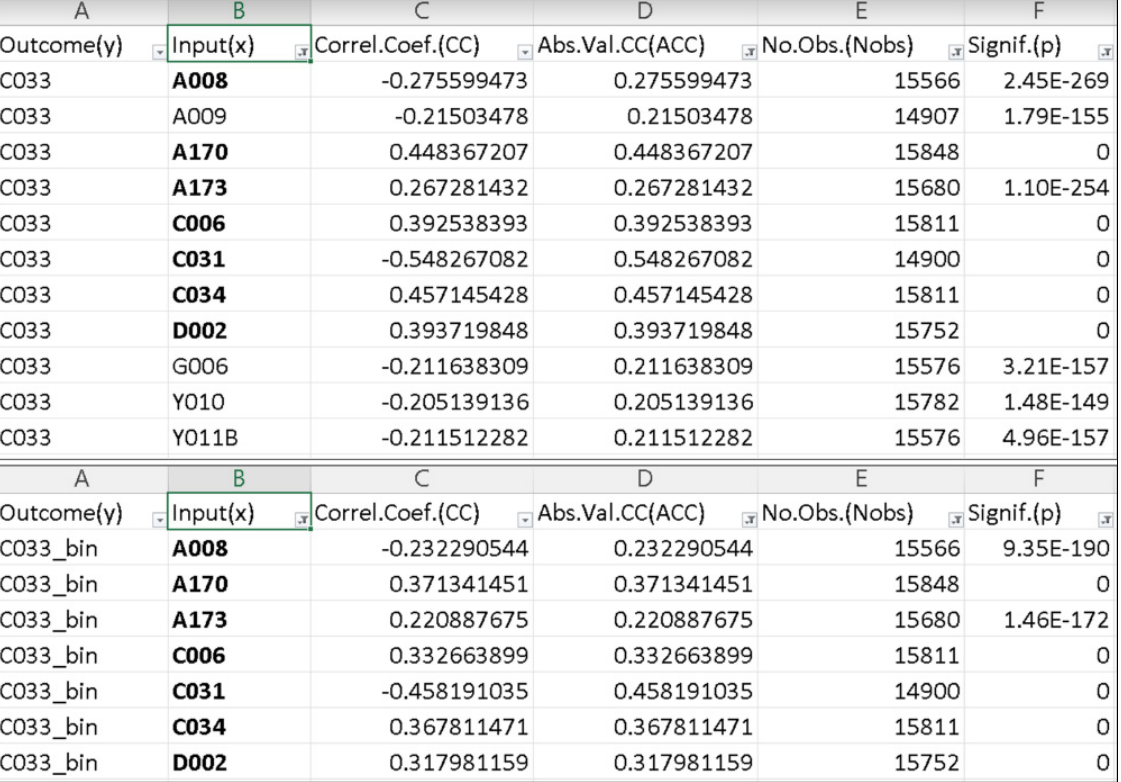
Figure 5. Seven intersecting results after two selection rounds using PCDM in its simple format for both forms of the outcome and further visual filters in spreadsheet tools (Microsoft Office Excel). Note: The “E” followed by the minus (“ − ”) and a value indicates the E notation corresponding to the scientific one (2.45E-269 is actually 2.45 × 10 − 269 ).